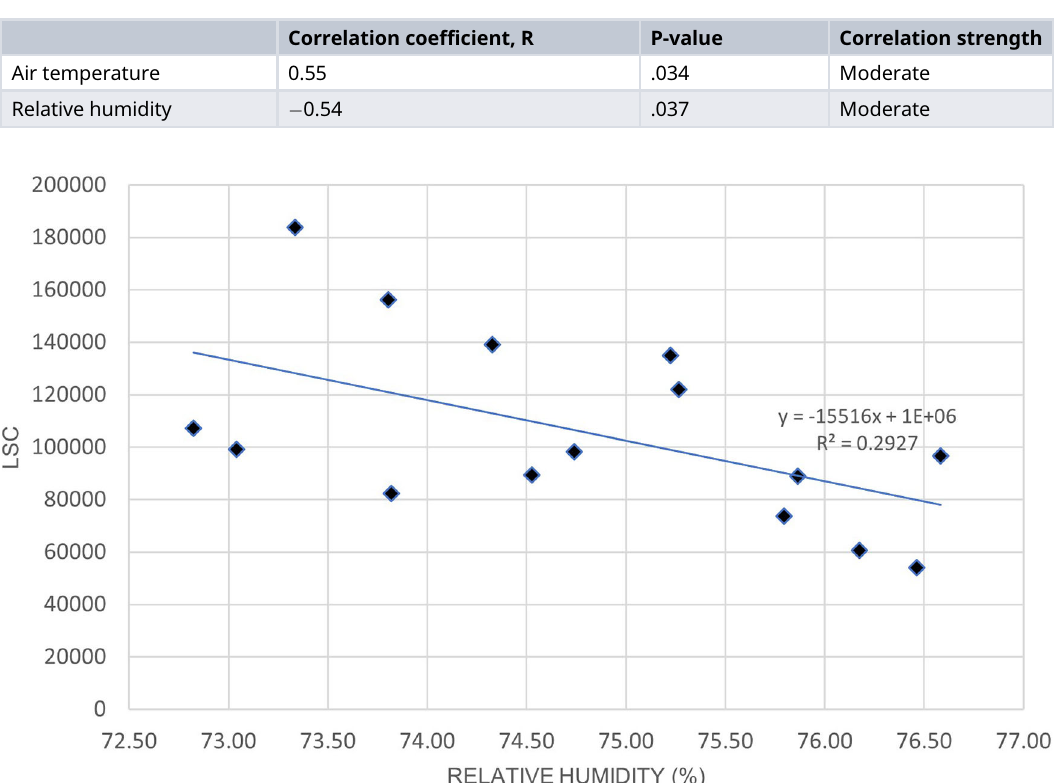
Table 8. Correlation strength of lightning strikes with air temperature and relative humidity in Oceania.